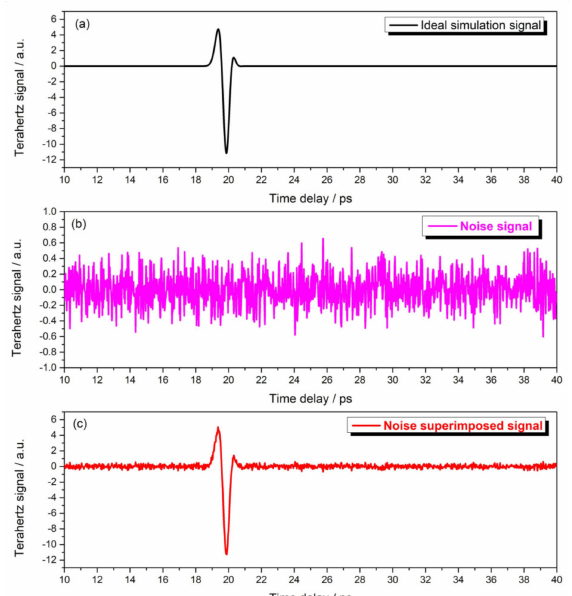
Figure 3. The process of adding Gaussian white noise to the terahertz simulation signal (taking the signal with thickness 0 µ m as an example): ( a ) ideal simulation signal; ( b ) noise signal; ( c ) noise superimposed signal.